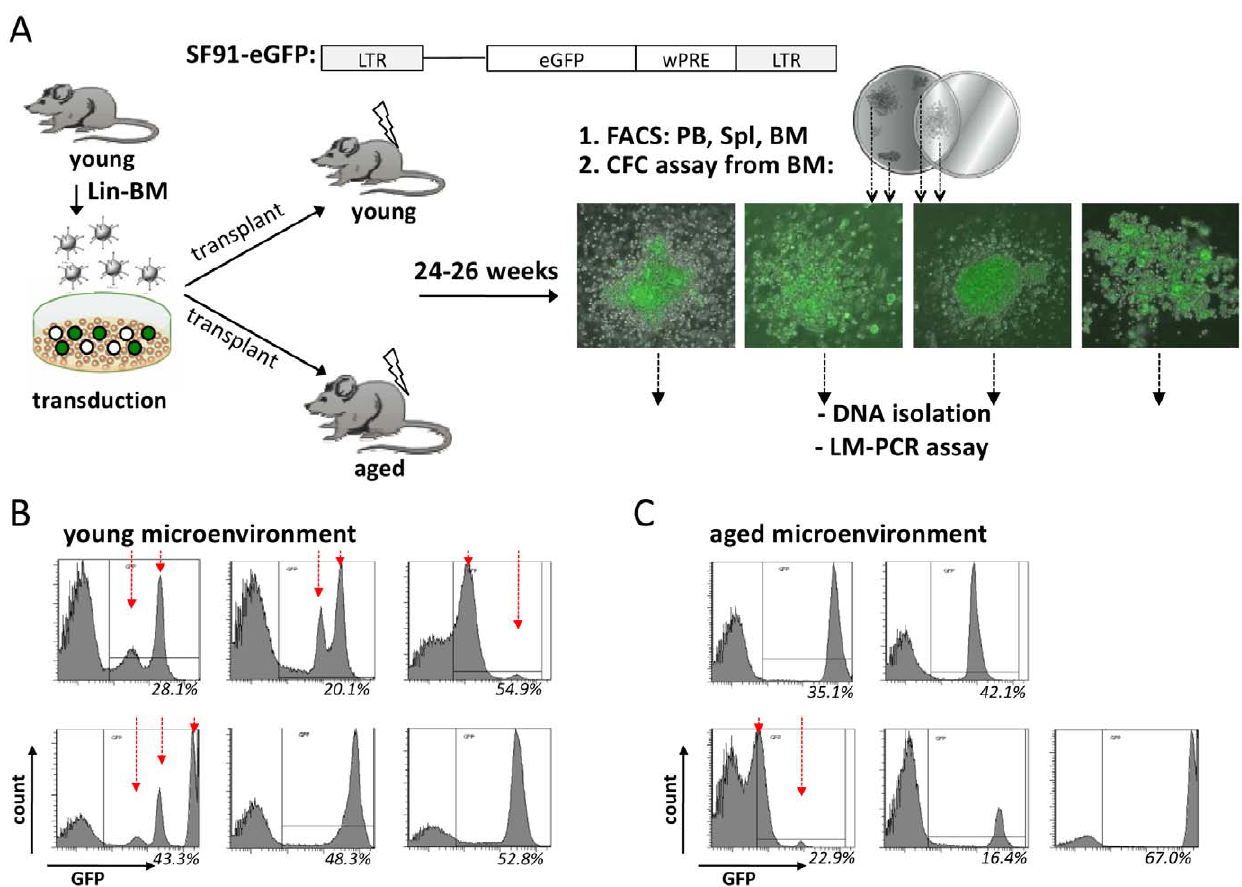
Figure 1. The clonal composition of the hematopoiesis is different in old compared to young microenvironment. (A) Schematic representation of the gammaretroviral SF91/IRES-eGFP vector used for insertional mutagenesis and the experimental setup (LTR: long terminal repeat with strong enhancer element, wPRE: woodchuck hepatitis virus posttranscriptional regulatory element). Lineage depleted (lin-) BM cells from young C57BL/6 mice were pre-stimulated with a cytokine cocktail and transduced. Cells were subsequently transplanted in equal amounts into young and aged recipient mice. (The graft contained 51.6%, 30.7%, 32.4% GFP + cells in the 3 transduction/transplantation.) 24–26 week post-transplantation recipients were sacrificed and PB, spleen and BM analyzed by flow cytometry for lineage differentiation markers as well as the number of primitive L- S + K + cells. At the same time CFC-assays on BM cells were performed and DNA from GFP + colonies (representative pictures) isolated for LM-PCR. GFP expression among BM cells of young (B) and aged (C) recipient mice. (young mice n=6, aged mice n=5, from 3 independent